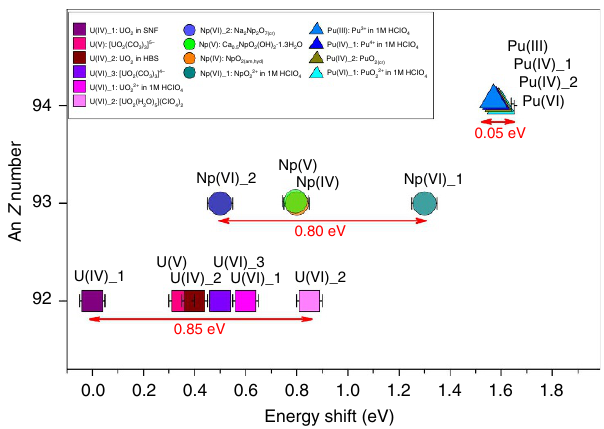
Figure 5 | Experimental HR-XANES spectra. U M 4 and Np/Pu M